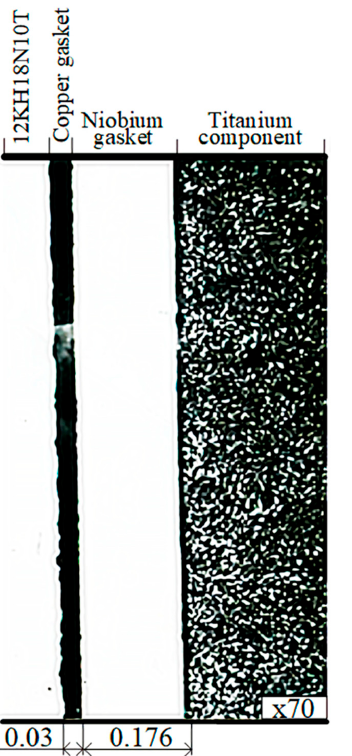
Figure 13. Connection area of 12KH18N10T stainless steel and copper.